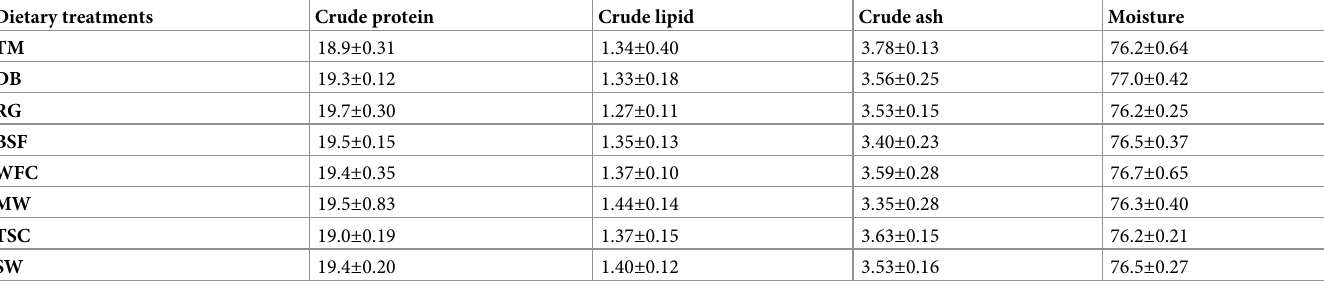
Values are mean of triplicates (n = 3) and presented as mean ± standard deviation. Different superscripts in each column indicate significant differences ( P < 0.05). Dietary treatments are abbreviated as: tuna byproduct meal (TM) as a fish meal, dynastid beetle (DB), rice grasshopper (RG), black soldier fly (BSF), white-spotted flower chafer (WFC), mealworm (MW), two-spotted cricket (TSC) and silkworm (SW).